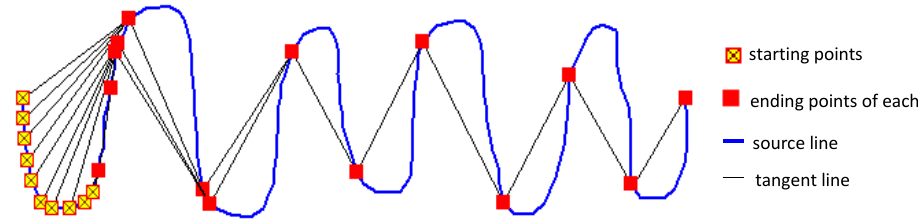
Figure 6. Effects of selecting different starting points on final division results.